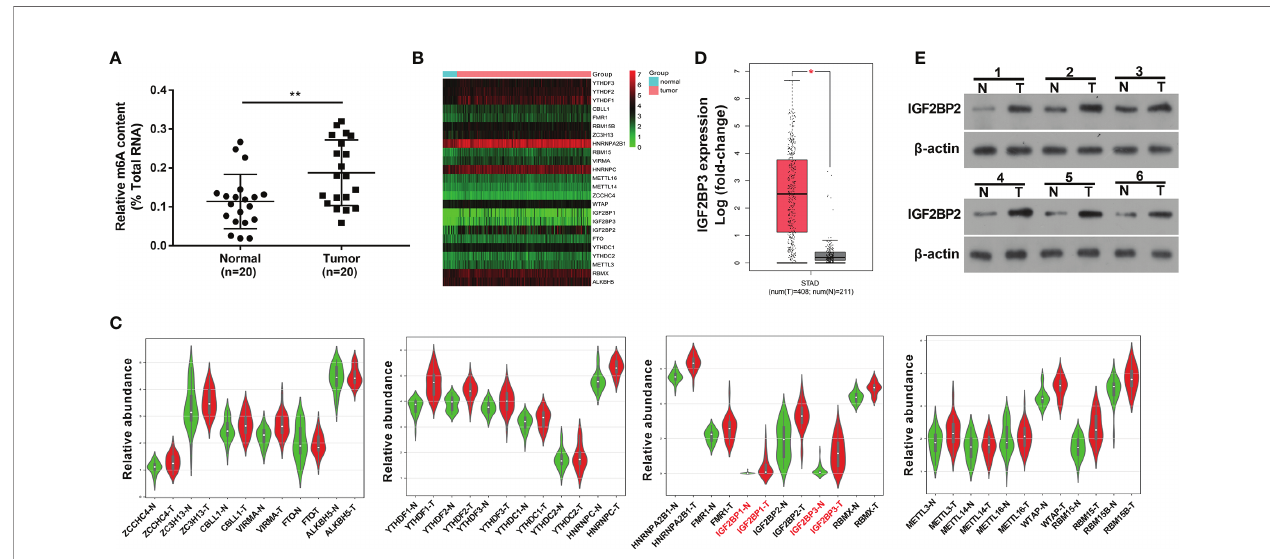
FIGURE 1 | M6A regulator IGF2BP3 was highly expressed in SC tissues. (A) Global m6A methylation level in total RNA was measured in 20 pairs of SC tumor tissues and adjacent normal tissues. (B) Expression heatmap of 24 m6A-related genes in 303 cases of SC tumor tissues and 32 cases of normal tissues. (C) Violin plots of 24 m6A-related genes in 27 pairs of SC tumor tissues and adjacent normal tissues. Violin plots were drawn using the bioinformatics website (http://www. bioinformatics.com.cn/plot_basic_vertical_horizontal_violin_plot_068). (D) Expression analysis of IGF2BP3 in SC tumor tissues (n=408) and normal tissues (n=211). The fi gure was drawn by the GEPIA website (http://gepia.cancer-pku.cn/). (E) Expression level of IGF2BP3 in 6 pairs of SC tumor tissues and adjacent normal tissues was measured by western blot assay. * p < 0.05, ** p <